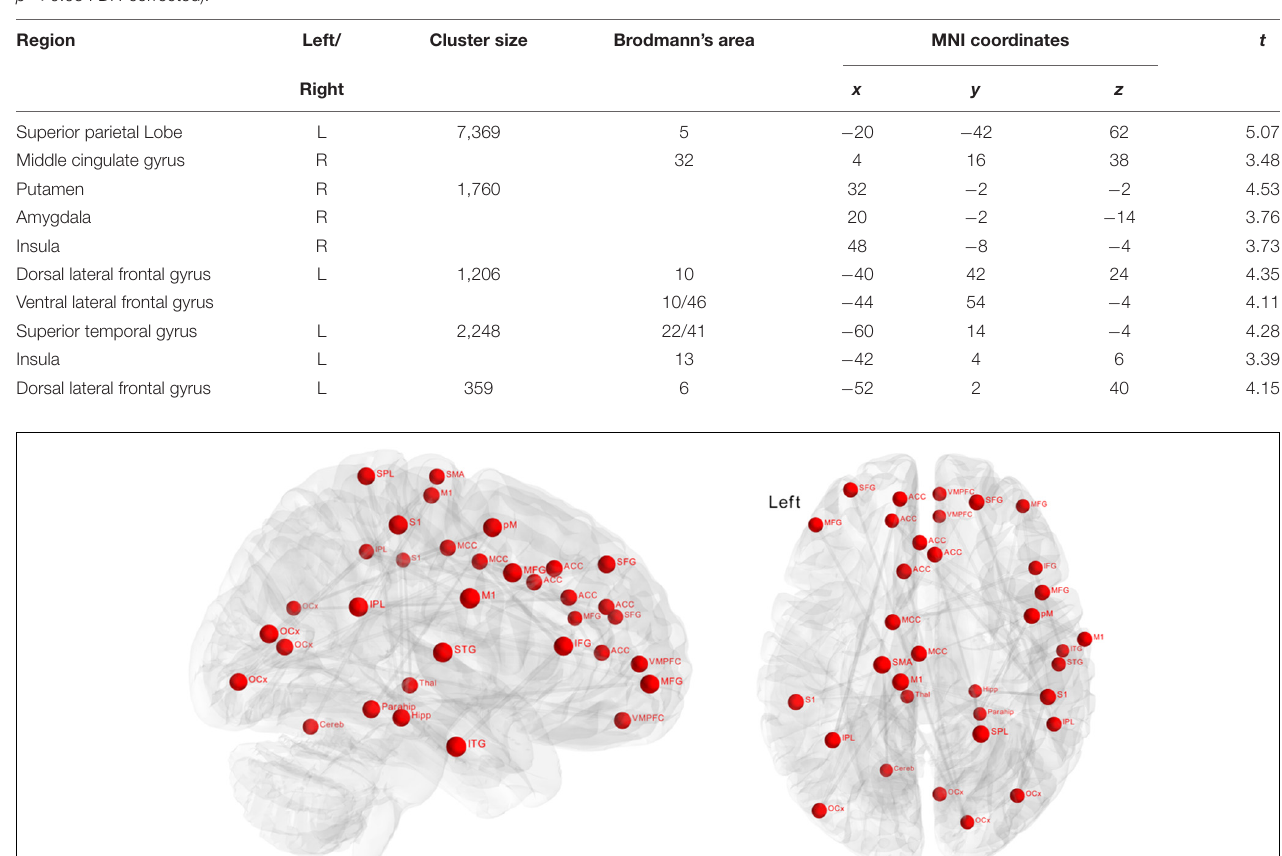
TABLE 3 | Interaction effect time × group on changes of functional connectivity of the prefrontal cortex (voxel-level: p < 0.005 uncorr., cluster-level: p < 0.05 FDR-corrected). Region Left/ Cluster size Brodmann’s area MNI coordinates t Right